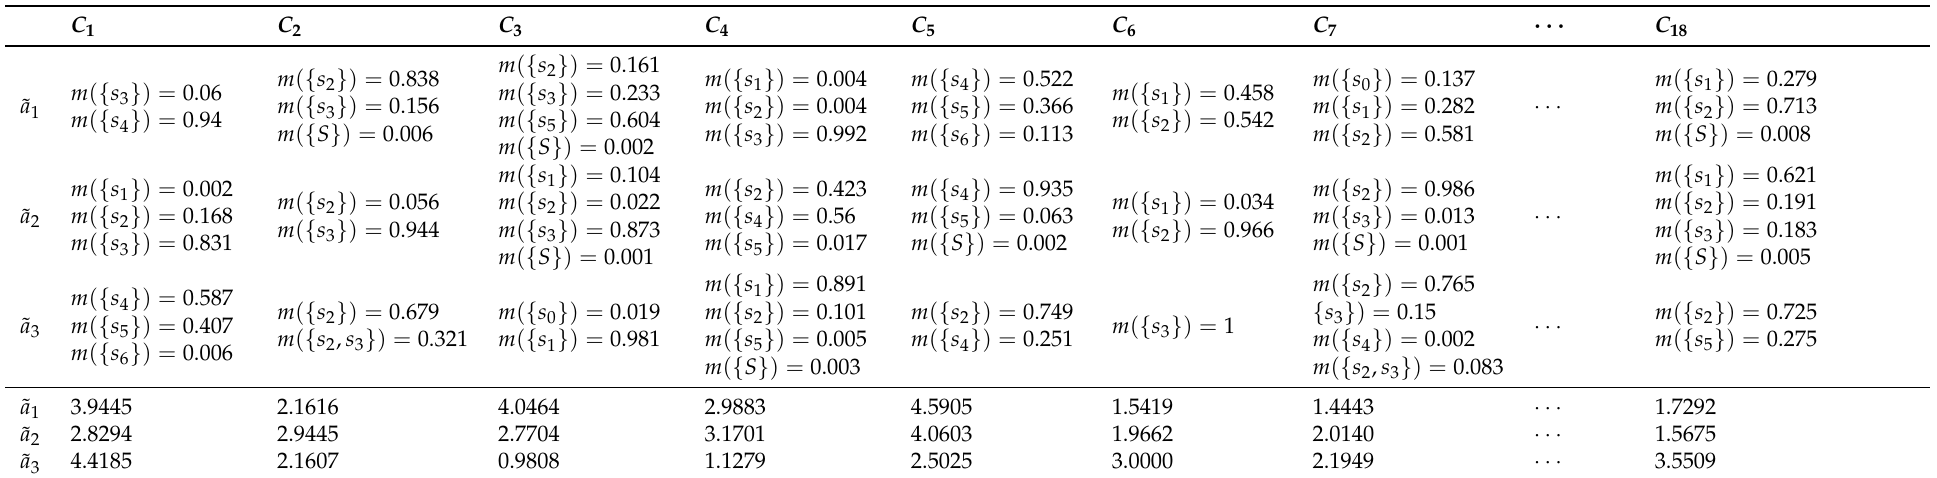
Table 6. Fusion and numerical representation of the expert evaluation